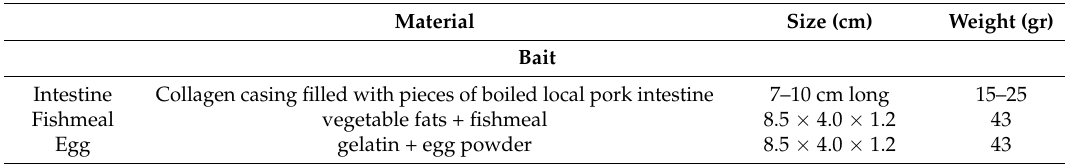
Table 1. Summary of the three bait types